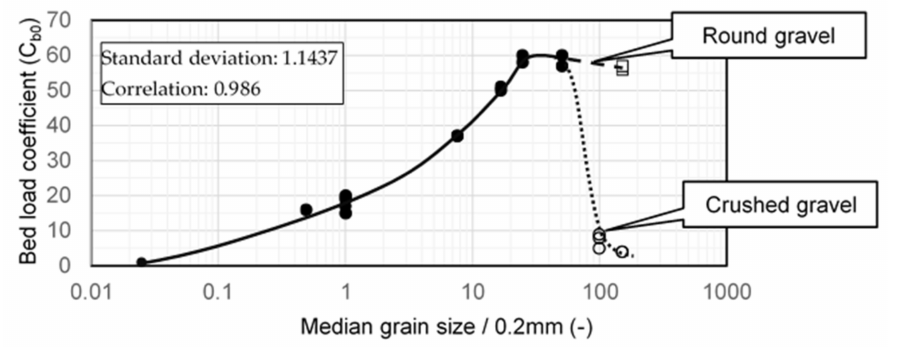
Figure 5. Influence of the median grain size to the bed-load coefficient (Uniformity coefficients are 1.5~3, dry densities are around 1.5 g/cm 3 ).